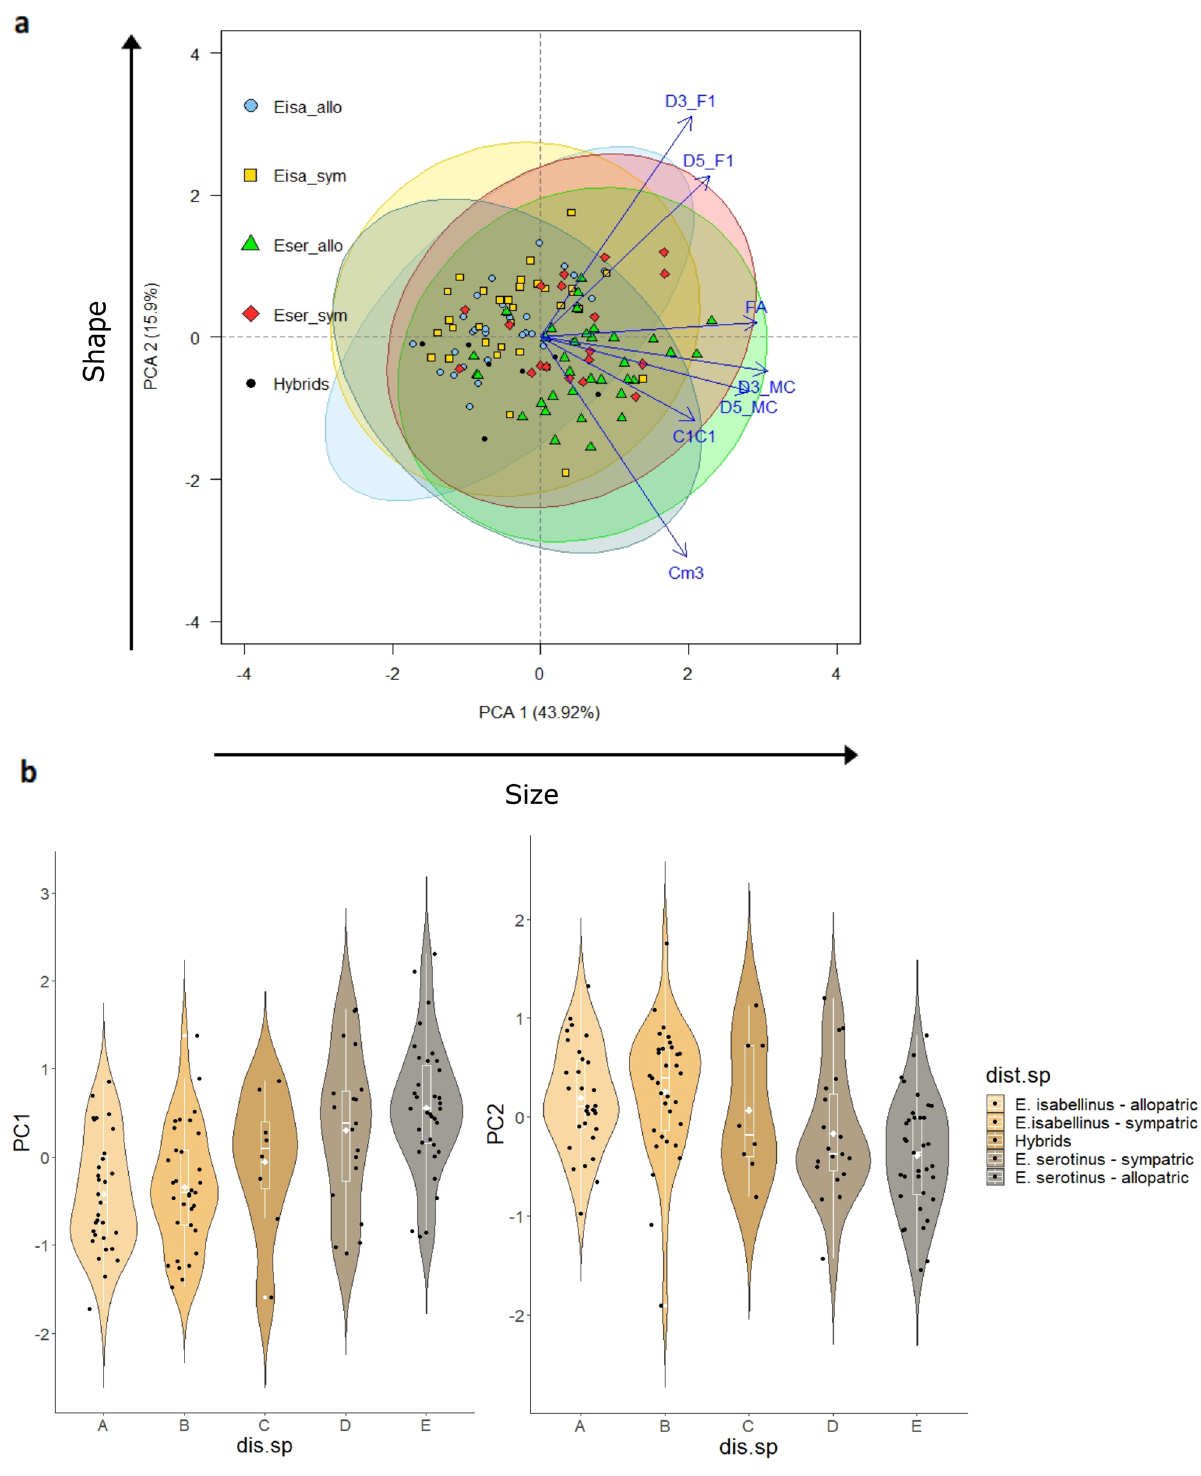
Figure 2. Principal Component Analyses of morphometric variables. Positioning of each individual in the two-dimensional space defined by the main PCA components retained and their position relative to the original morphometric variables ( a ). The violin plots represent E. isabellinus (allopatric and sympatric), E. serotinus (allopatric and sympatric) and Hybrids PCA scores compared to size (PC1) and shape (PC2) ( b ). Within violin plots, white solid lines boxplots include medians (horizontal white line) and averages (white dot); boxes and vertical white lines indicate quartiles and ranges (excluding outliers), respectively. Acronyms are available in Table 1 (dist.sp: species